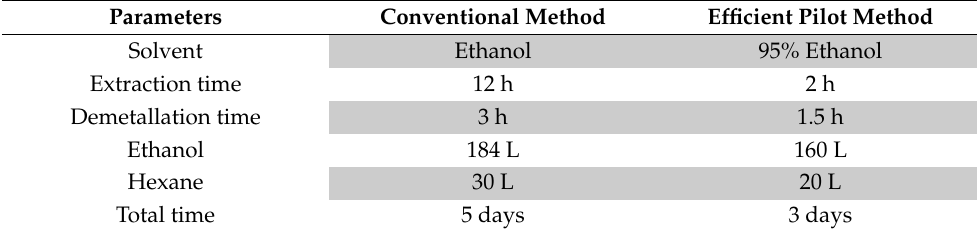
Table 1. Efficiency of new modified method over conventional method.